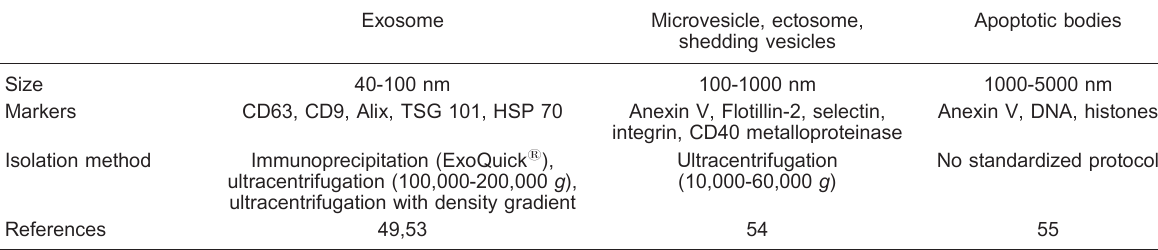
Table 1. Main differences between extracellular vesicles, in vitro isolation methods, cargo, size, and function.